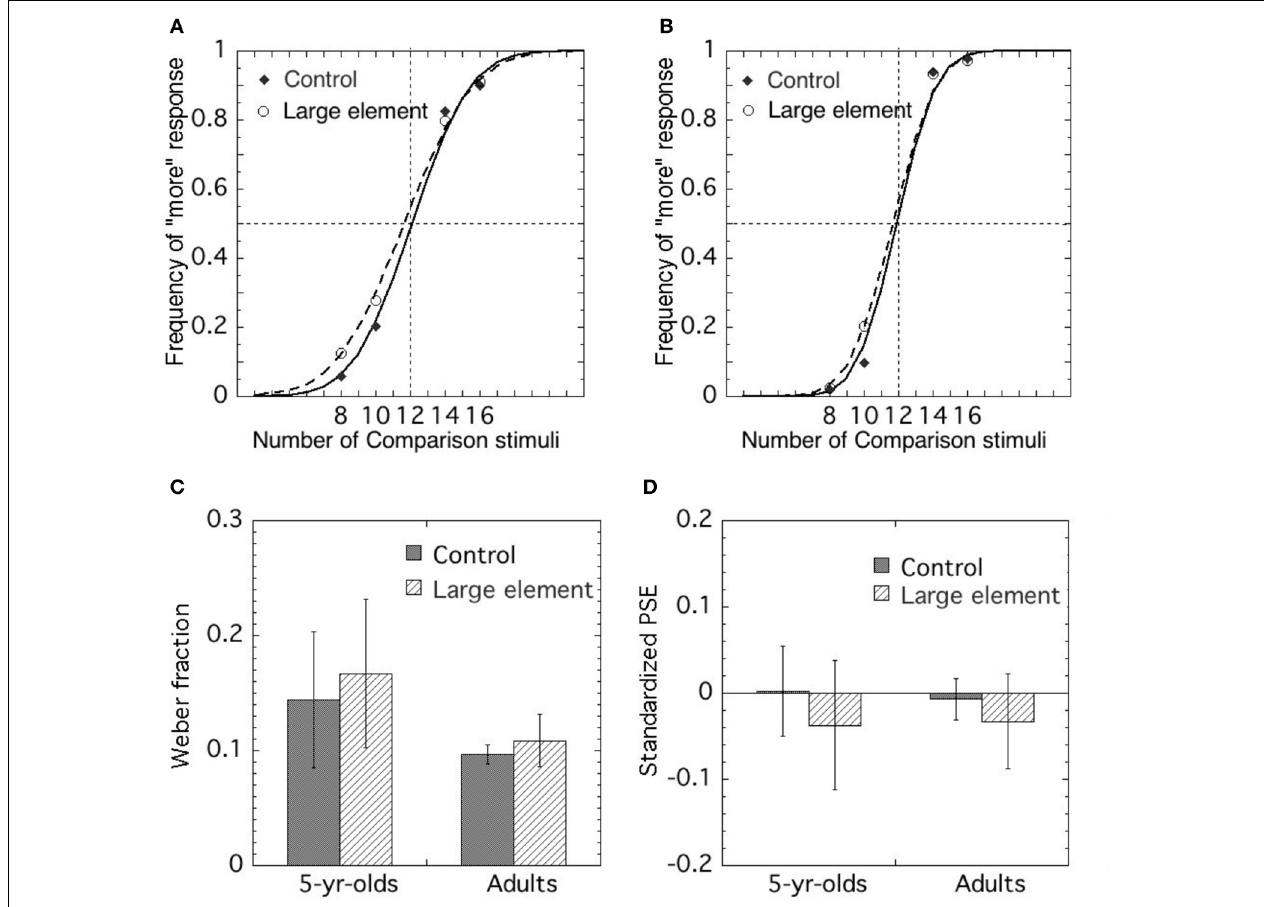
FIGURE 3 | Choice frequency of more elements as a function of the number of comparison stimuli in (A) 5-year-olds and (B) adults. Mean Weber fraction (C) and standardized PSE (D) of each condition in 5-year-olds and in adults. Error bars represent standard